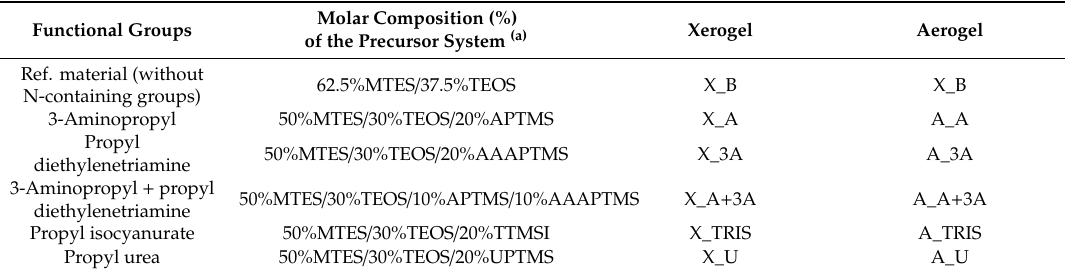
Table 1. Aerogel / xerogel functional groups and samples nomenclature.